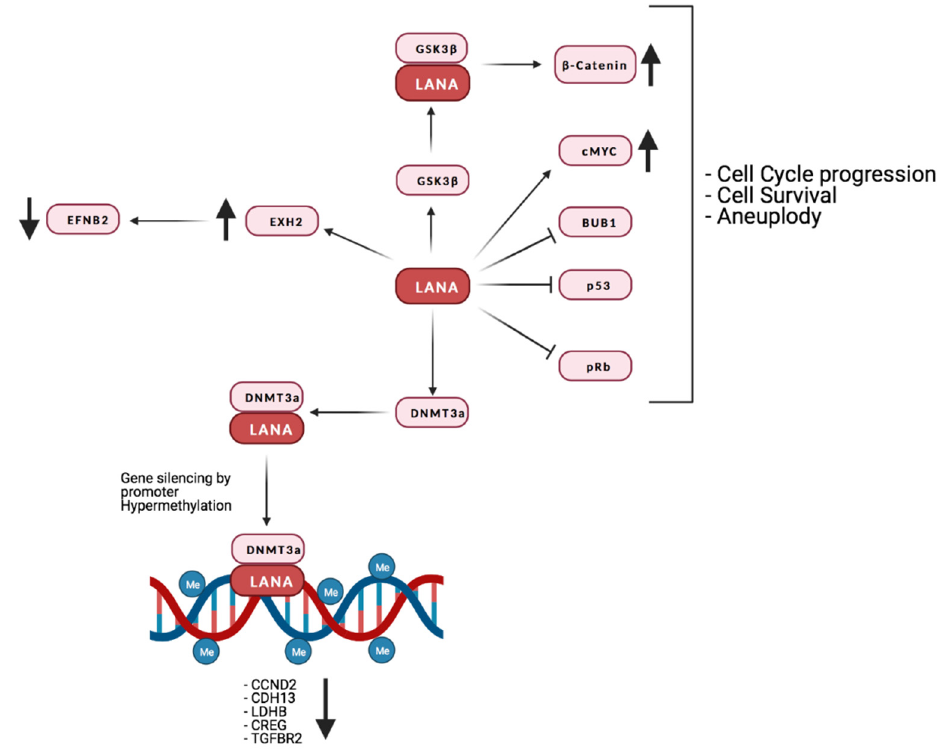
Figure 4. Summary of LANA’s interaction with the host’s proteins and their effect on the host’s gene expression. Credits: Created with BioRender.com.